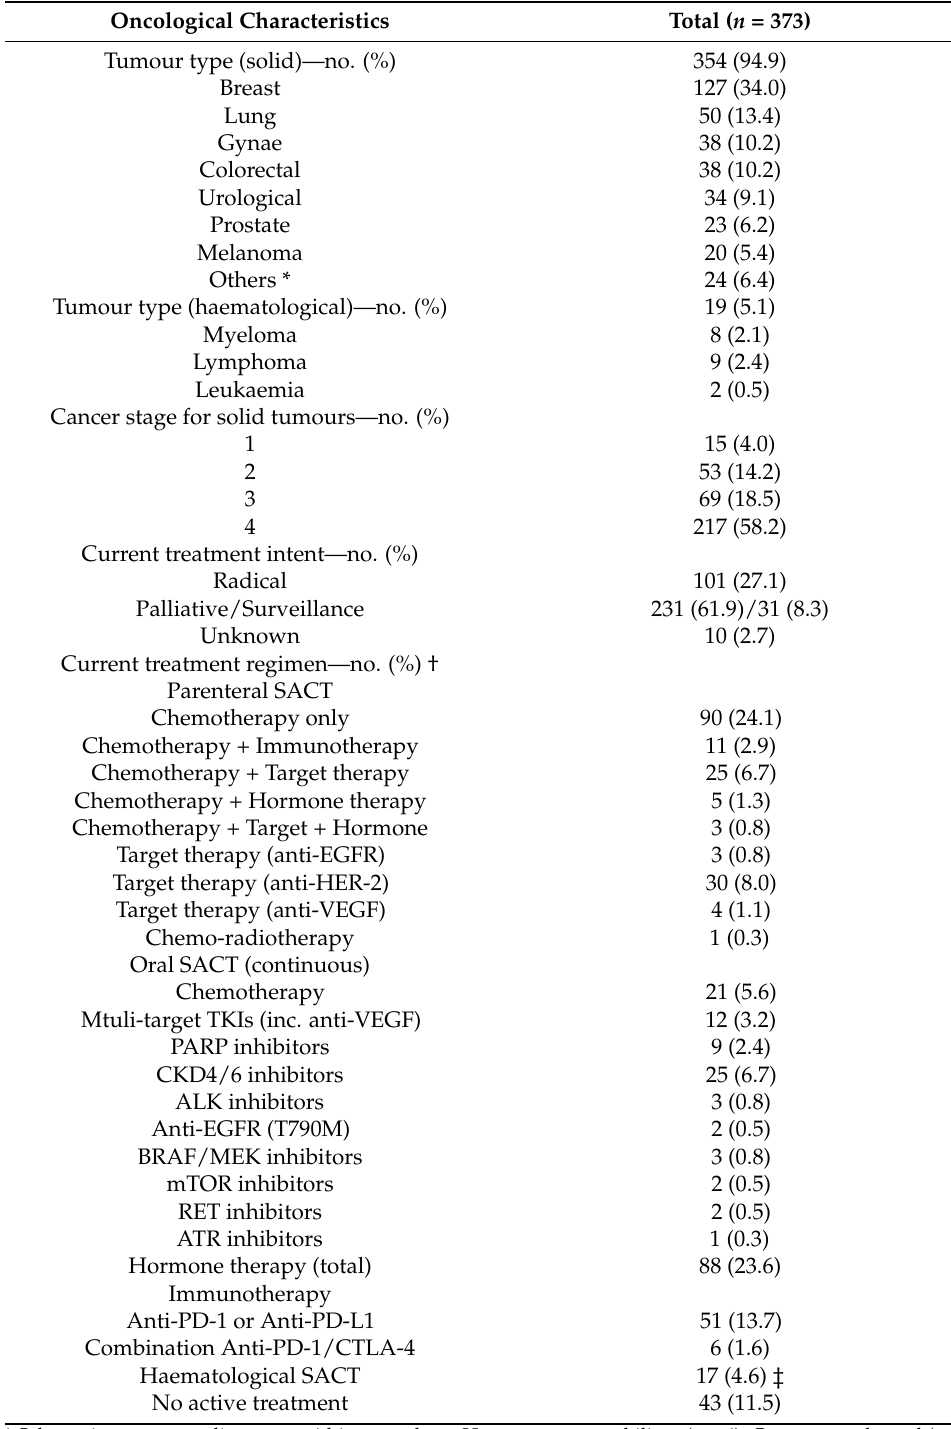
Table 3. Oncological characteristics. SACT, systemic anti-cancer therapy. TKI, tyrosine kinase